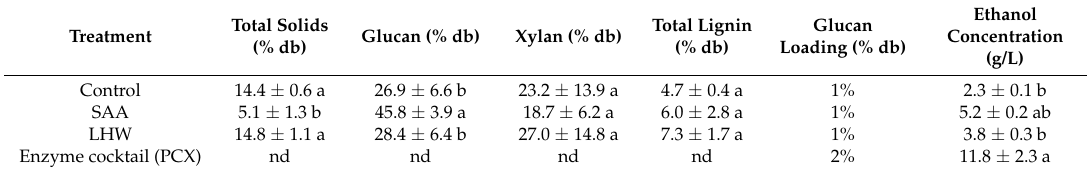
Table 1. Composition of pretreated IF subjected to simultaneous saccharification and fermentation (SSF) with S. cerevisiae